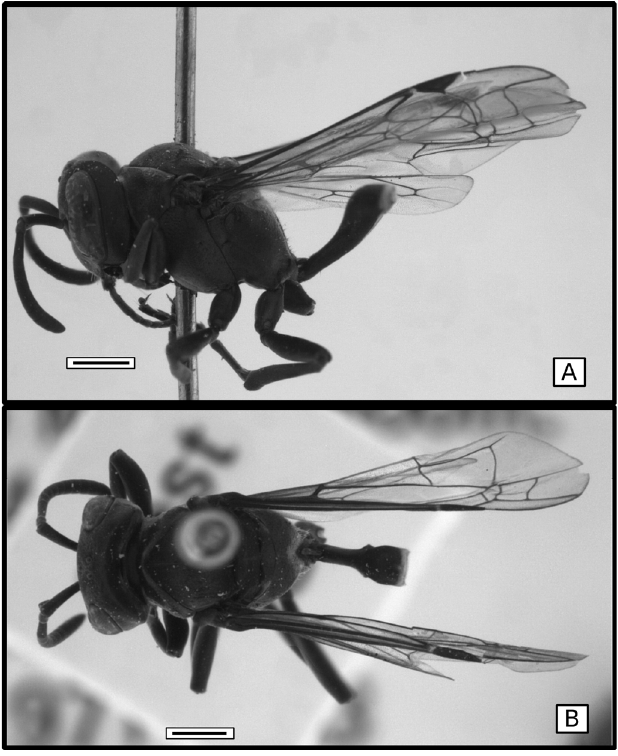
Fig 1 . Metapolybia fraudator from Peru, Tingo Maria (Nest G): A= lateral view; B= dorsal view. Escale bar = 1.0 mm.